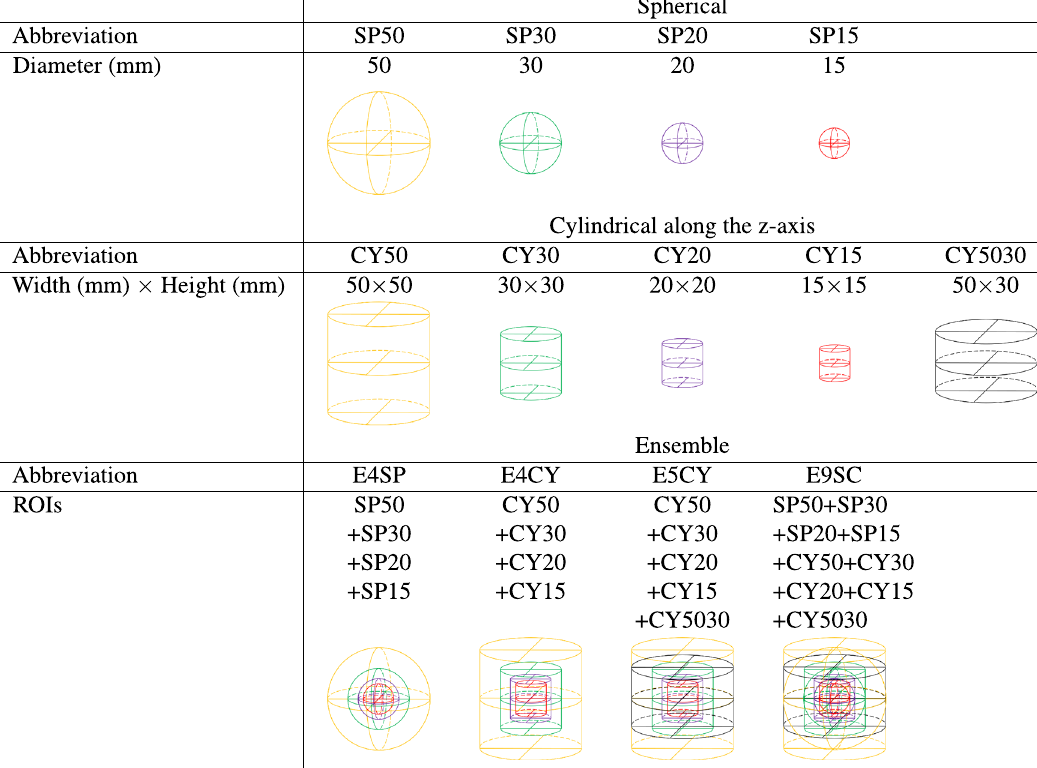
Table 3. The characteristics of the ROIs used in this study. ROIs from the planning-CT images were segmented using cylindrical and spherical ROIs with various sizes around the expert-labeled BM and HB